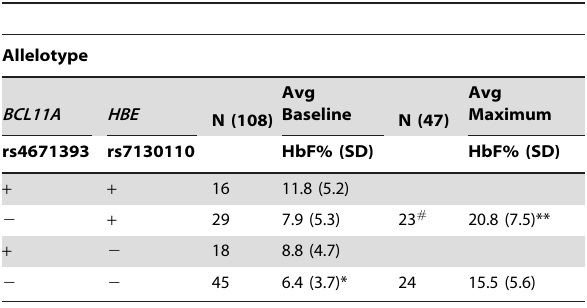
Table 2. Incremental effect of allelotypes in BCL11A and HBE on Baseline and Maximum